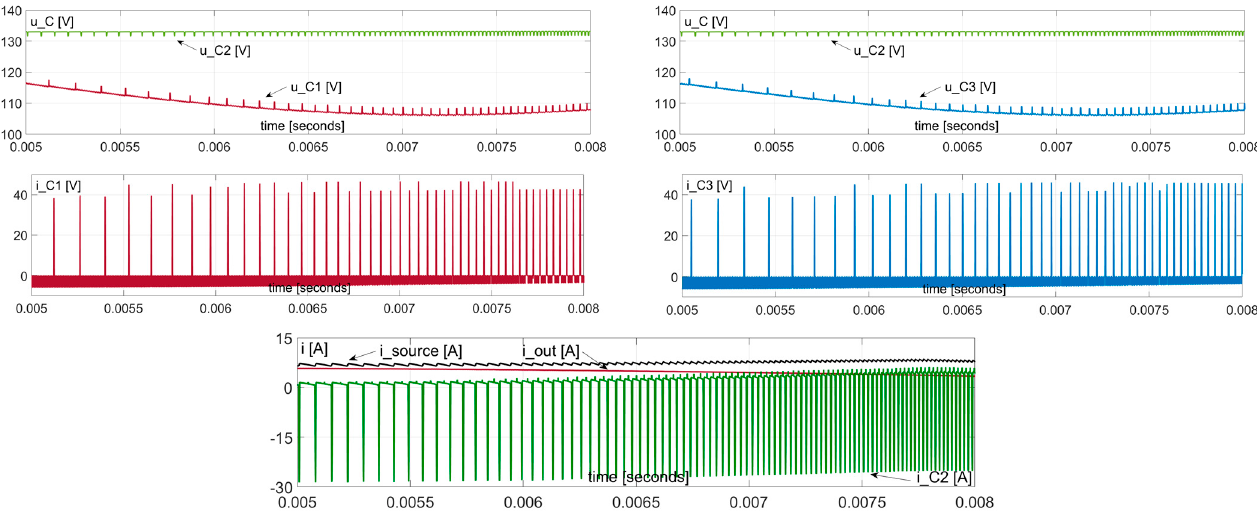
Figure 15. AIVB operation with variable frequency. Steady state waveforms of voltages and currents of DC-link capacitors of the seven-level inverter with three input voltage sources. 500 μ s/div. P out = 1 kW, L f = 6 μ H.